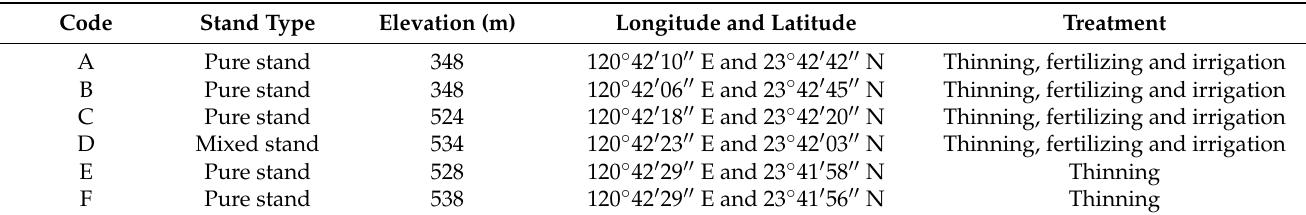
Table 1. Detailed information on the Ma bamboo stands used in this study